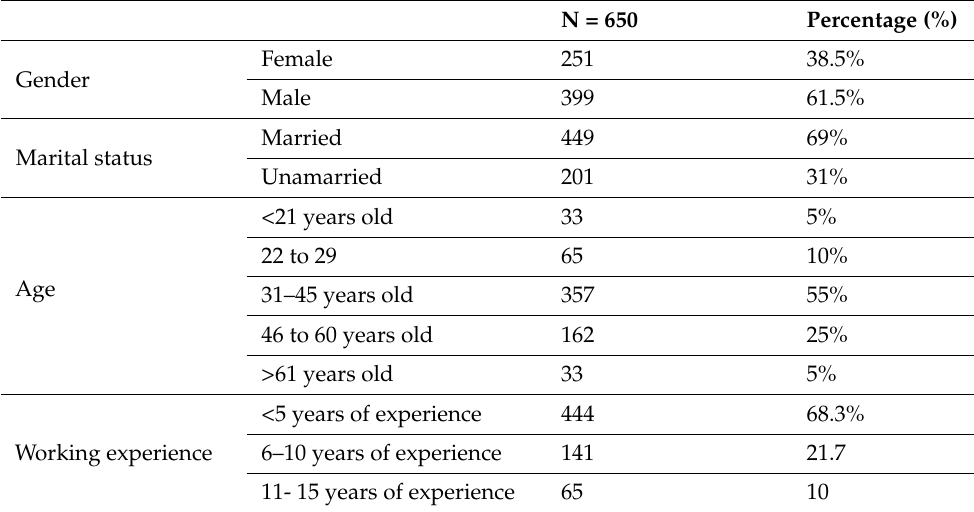
Table 1. Respondents’ Demographics.